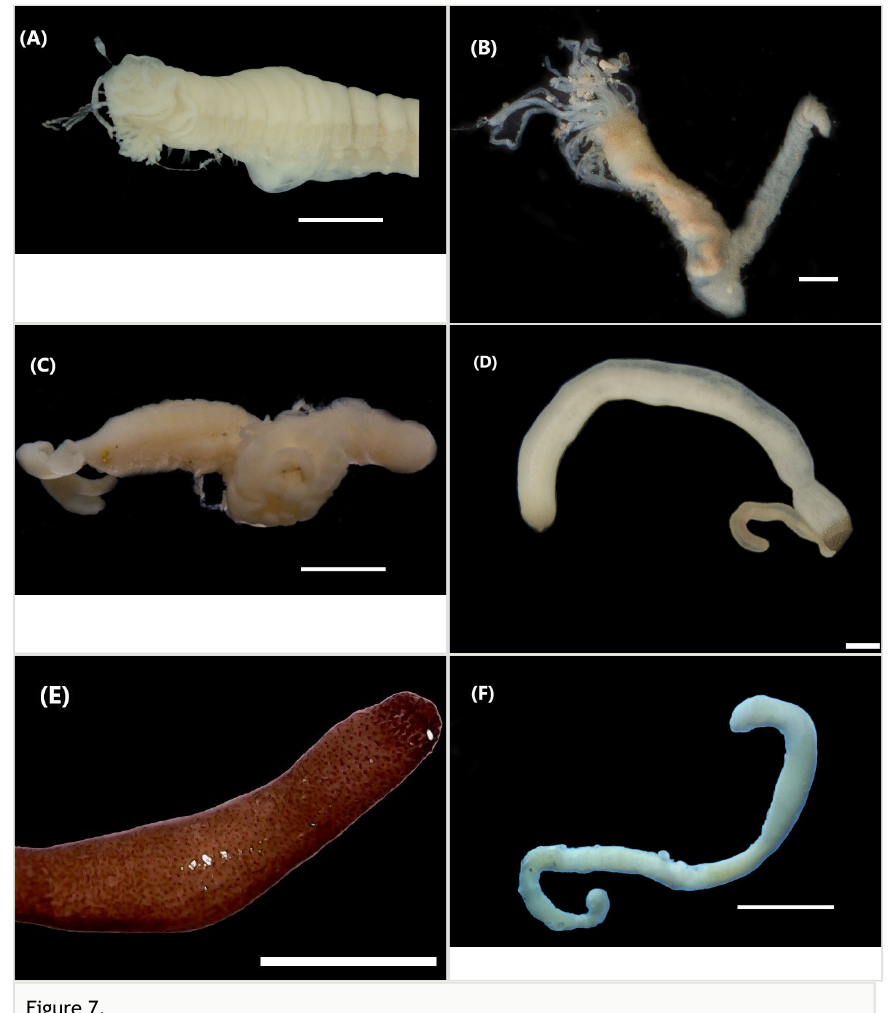
Annelids polychaetes and sipunculids identified on the beaches from Paraíba coast. Scale bars = 1 mm (A-F). Photos: (A) by Prata, J.; (B-D,F) by Freitas, P.; (E) by Costa,